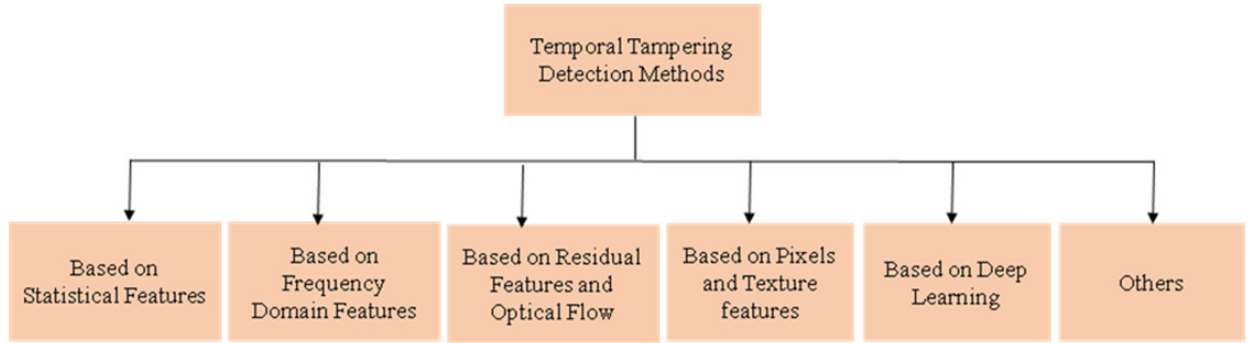
Figure 6. Categories of temporal tampering detection